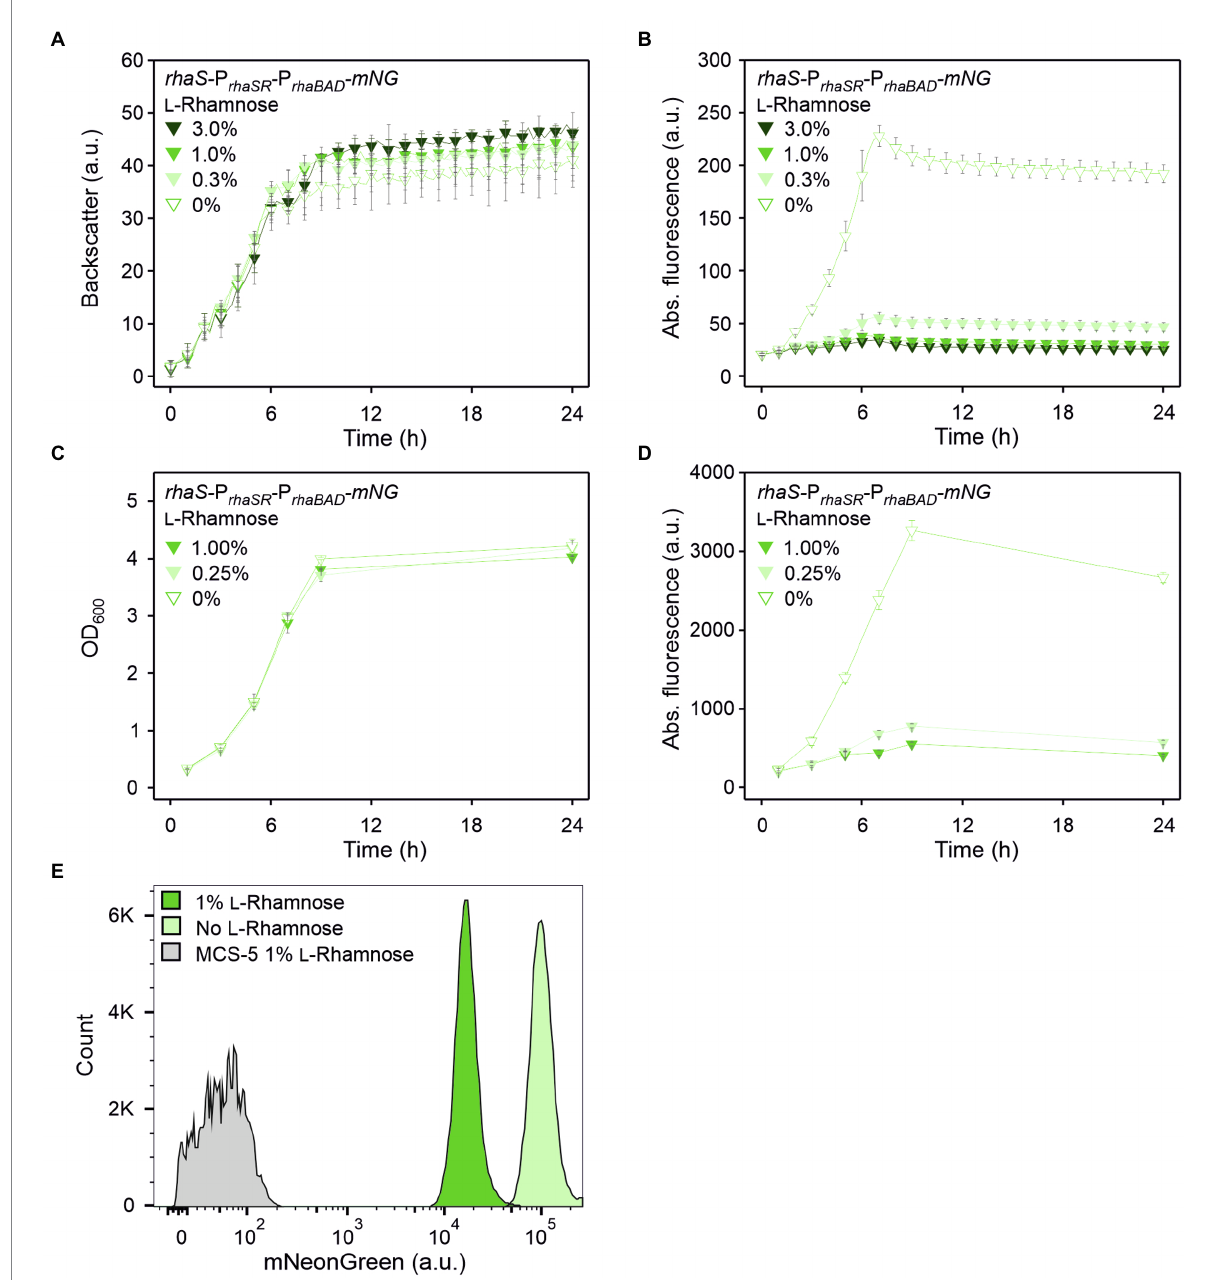
FIGURE 3 RhaS-dependent repression of P rhaBAD in G. oxydans in the presence of l -rhamnose. (A) Growth according to backscatter and (B) absolute mNG fluorescence in G. oxydans 621H with plasmid pBBR1MCS-5- rhaS -P rhaSR -P rhaBAD -mNG in microscale BioLector cultivations without or with l -rhamnose (w/v) as indicated. BioLector settings: backscatter gain 20, fluorescence gain 40. (C) Growth (OD 600 ) and (D) absolute mNG fluorescence in G. oxydans 621H with plasmid pBBR1MCS-5- rhaS -P rhaSR -P rhaBAD - mNG in shake flask cultivations without and with l -rhamnose (w/v) as indicated. mNG fluorescence was measured in a Tecan reader (gain 60). Data represent mean values and standard deviation from two biological replicates (clones) with three technical replicates each. (E) FACS analysis of G. oxydans 621H with plasmid pBBR1MCS-5- rhaS -P rhaSR -P rhaBAD - mNG or empty vector pBBR1MCS-5 as a control (MCS-5). Cells were grown in shake flasks with d -mannitol medium without and with 1% (w/v) l -rhamnose. FACS analysis was performed 7 h after inoculation (induction). Total counts per sample represent 100,000